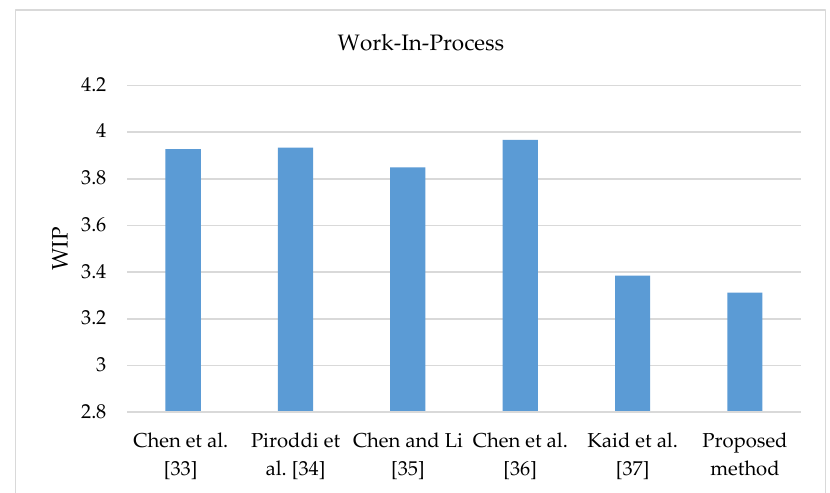
Figure 13. Comparison of WIP for the Petri net model in Figure 2.